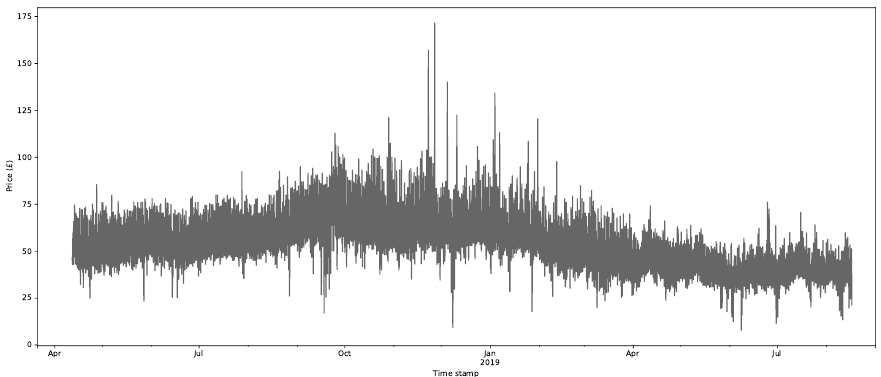
Figure 3. Estimates of the clearing price for the period 11 April 2018 to 17 August 2019.